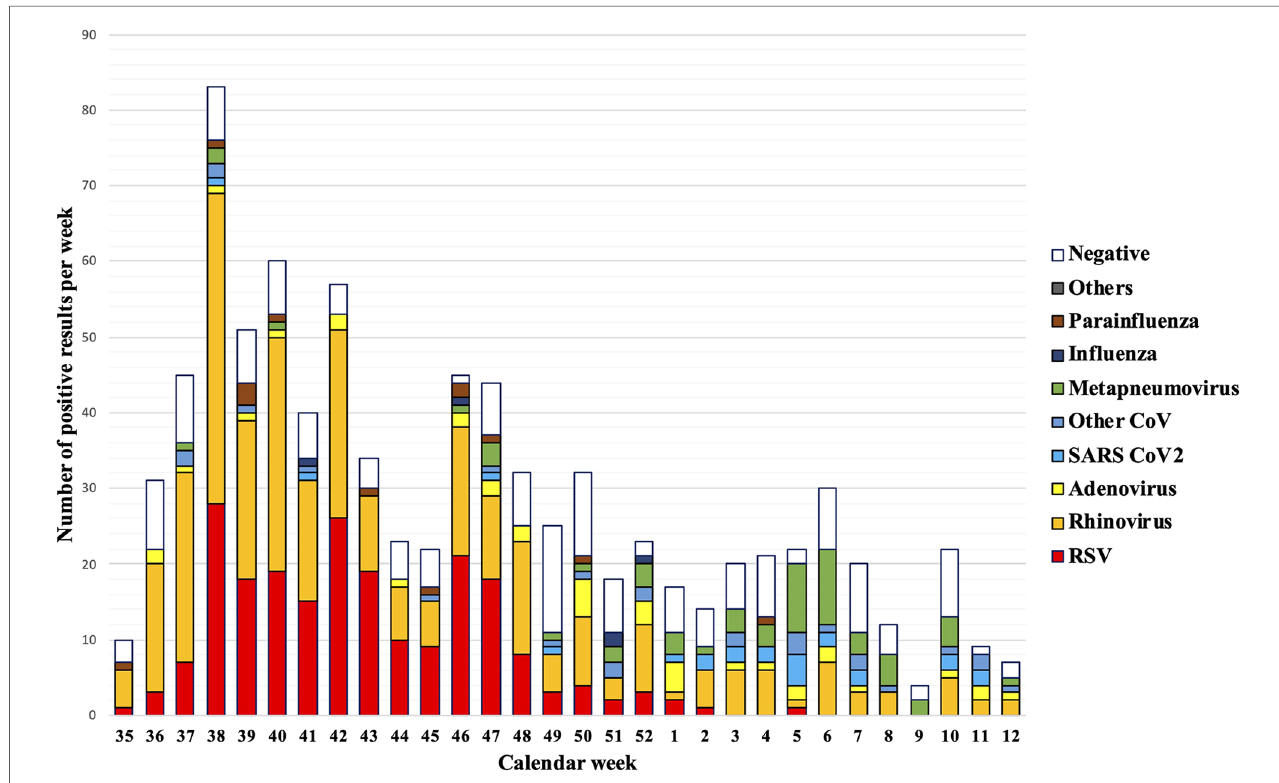
RSV cases and 32% of metapneumovirus cases were treated